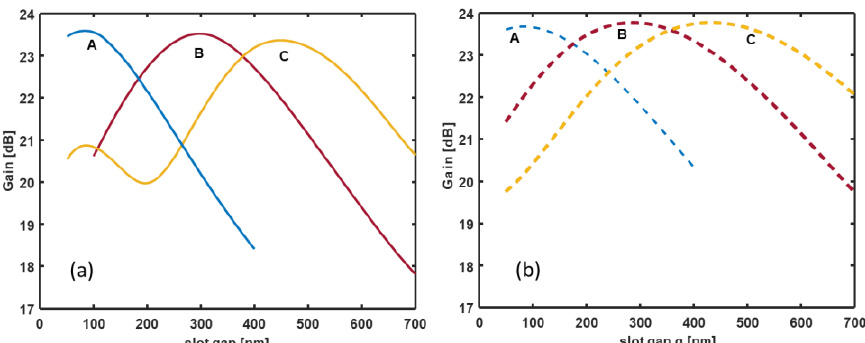
Figure 5. Maximum gain for ( a ) the TE (solid curves) and ( b ) the TM (dashed curves) in the case of the three configurations A (w = 600 nm), B (w = 900 nm), and C (w = 1100 nm). In all the considered cases, the gain maximum occurs at Φ = 0 and θ = π / 2. The antenna length is L a = 25 μm , and the wavelength is λ = 1.55 µm.